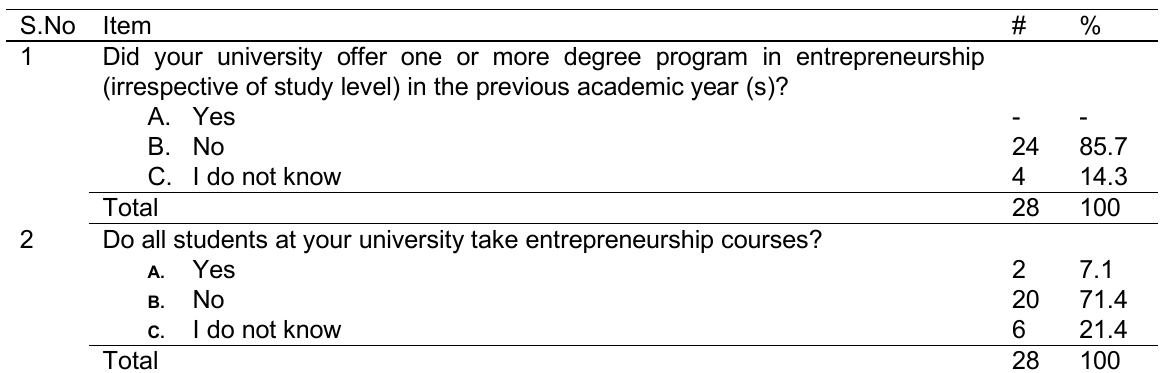
Table 3: University entrepreneurship program